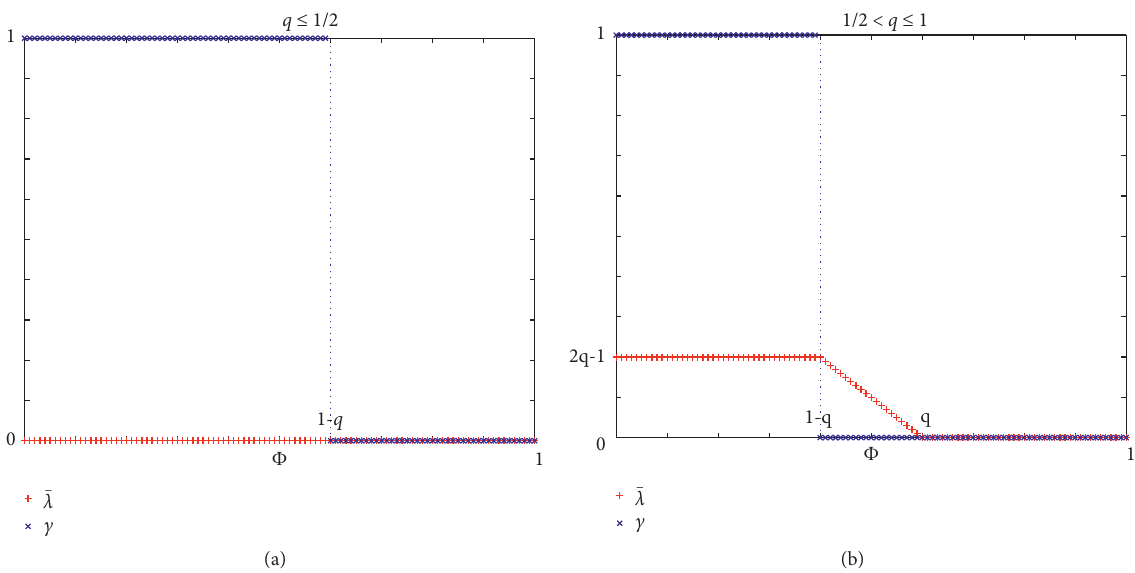
Figure 1: The impact of application fee on the participation of sellers under the given certification accuracy: (a) in the situation of q � 0 . 4 ≤ 1/2; (b) in the situation of 1/2 < q � 0 . 6 ≤ 1.